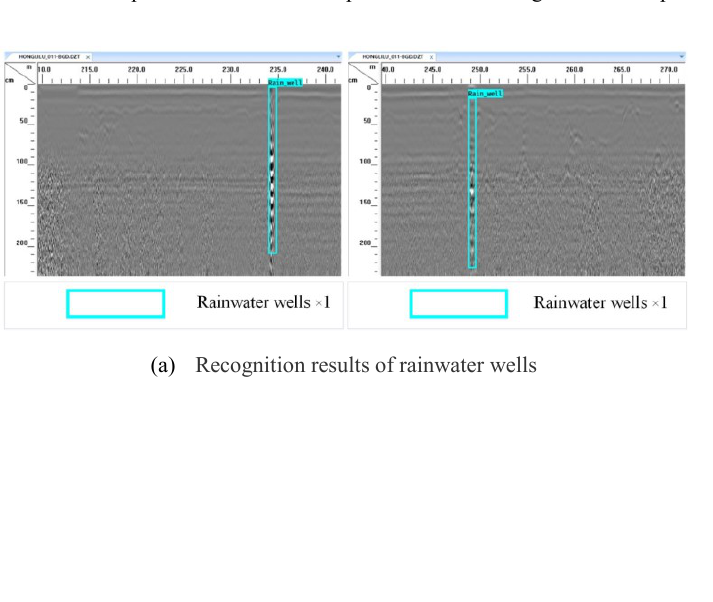
Table.2 Statistical quantitative table of samples of different categories after expansion